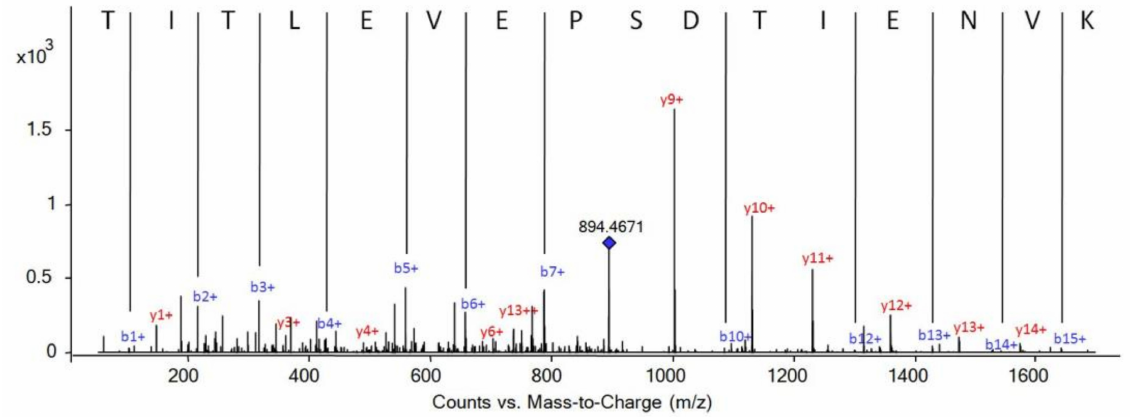
Figure 3. ESI-MS/MS spectra of Polyubiquitin-B peptide 12–27 (TITLEVEPSDTIENVK). Score 15.59, SPI 87.4%, 894.4671 m / z (shown with a blue diamond) ( z = 2). The y ions are shown in red and the b ions in